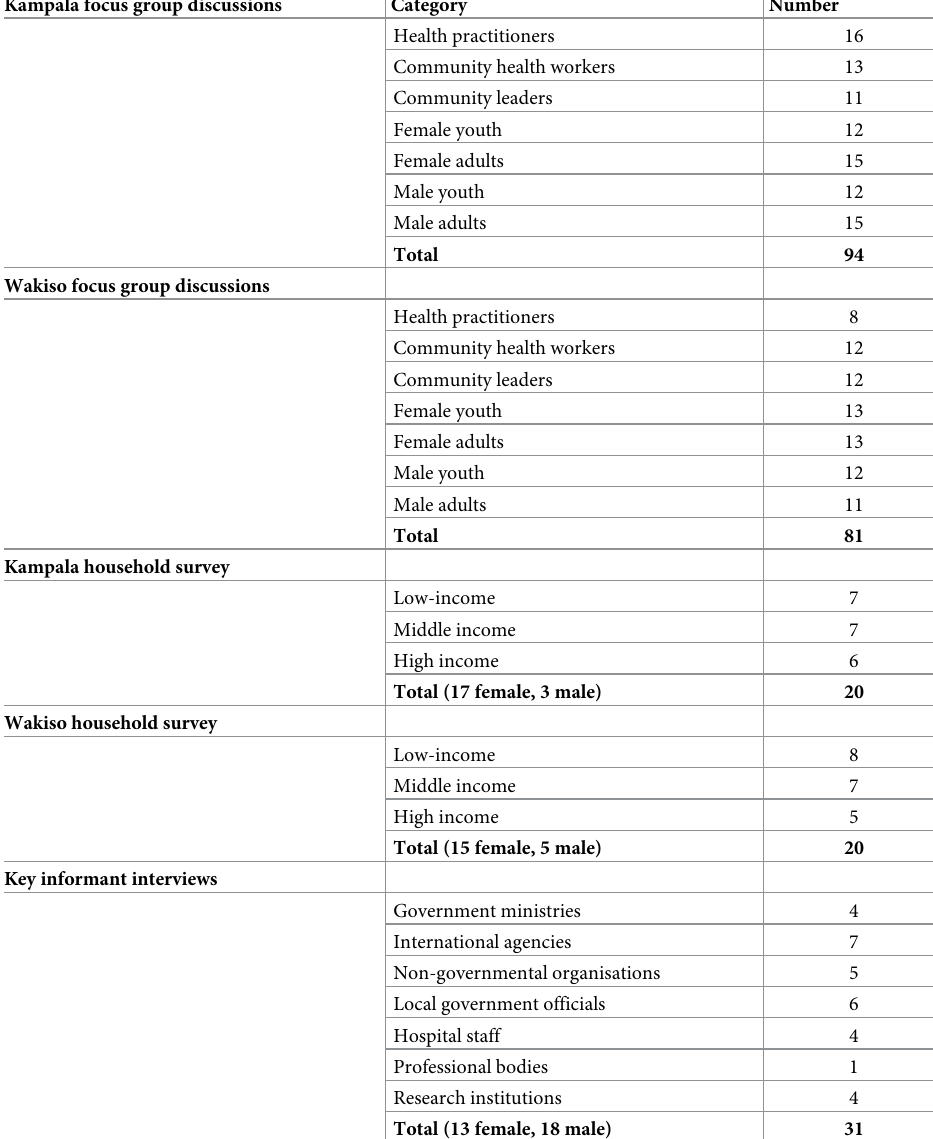
Table 1. Participants involved in the